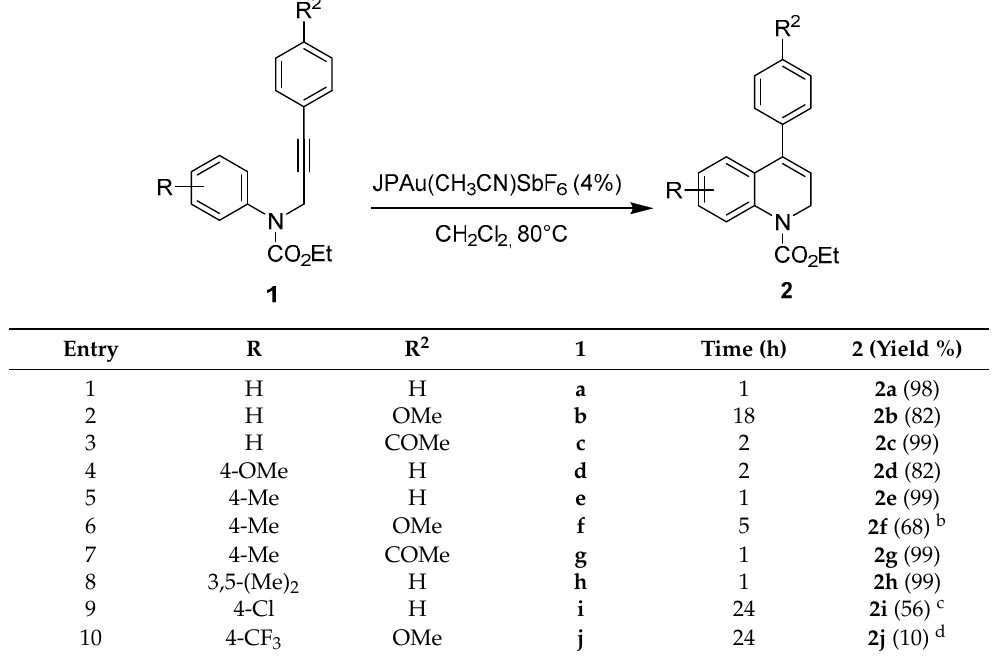
Table 2. Scope of the gold(I)-catalyzed IMHA of the N -ethoxycarbonyl- N -propargylanilines 1 a .